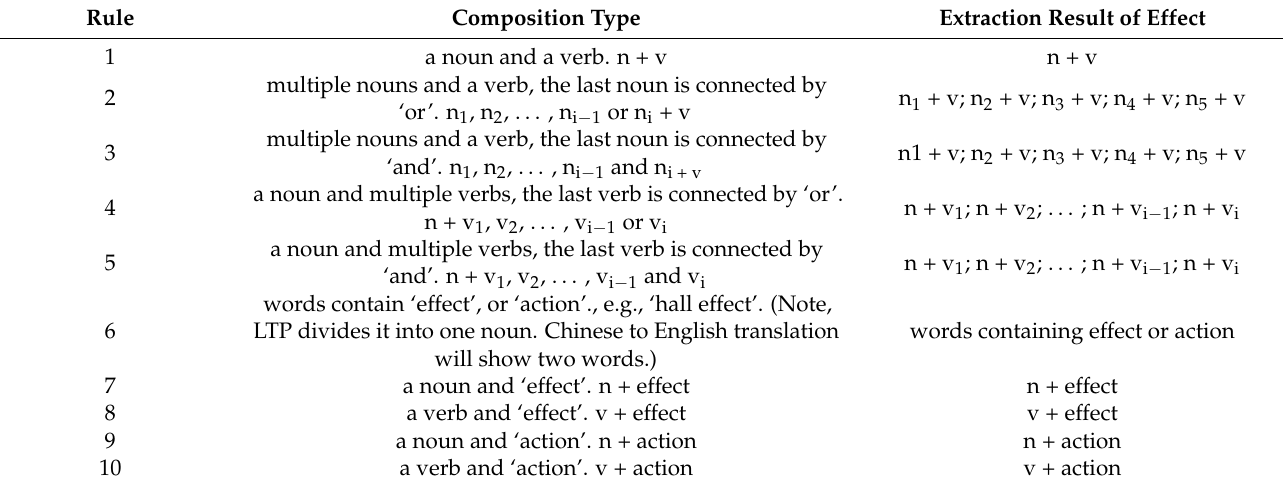
Table 2. Effect extraction rules.